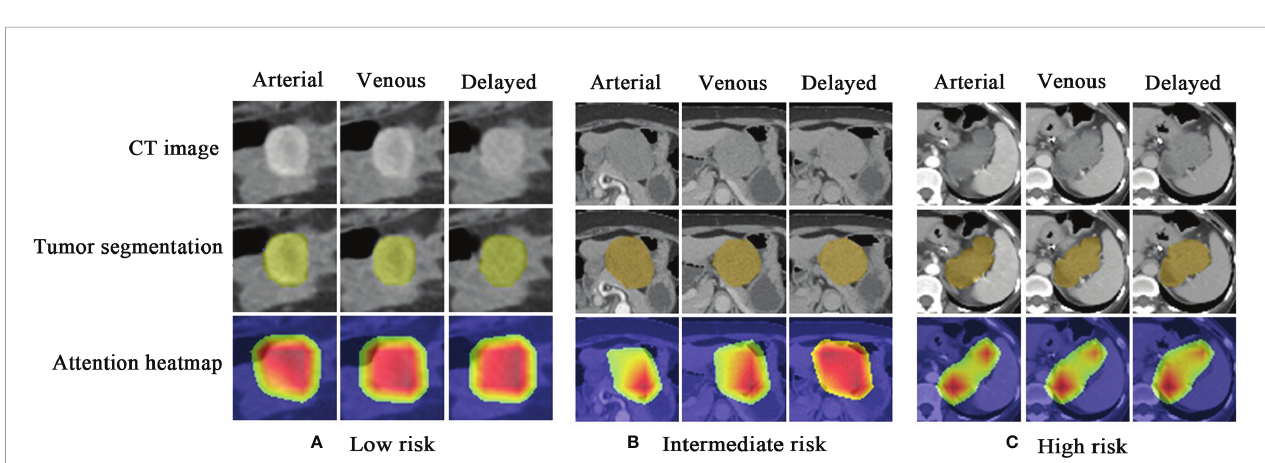
FIGURE 6 | Attention heatmap drawn by gradient-weighted class activation mapping for the model interpretation. (A) CT images, tumor segmentations, and corresponding attention heatmaps in a 60-year-old woman with low-malignant GIST (the fi rst column is arterial phase, the second column is venous phase, and the third column is delayed phase). (B) CT images, tumor segmentations, and corresponding attention heatmaps in a 66-year-old woman with intermediate-malignant GIST. (C) CT images, tumor segmentations, and corresponding attention heatmaps in a 43-year-old woman with high-malignant GIST. The red and yellow regions represent areas activated by the DLM and have the greatest predictive signi fi cance; the blue backgrounds re fl ect areas with weaker predictive values. GIST, gastrointestinal stromal tumor; DLM, deep learning model.